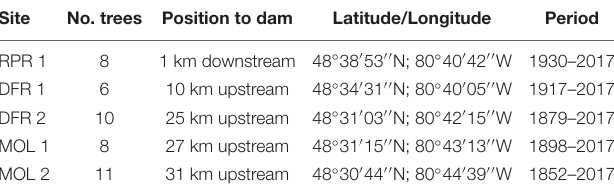
TABLE 1 | Location of sampling sites. TABLE 2 | Characteristics of Fraxinus nigra